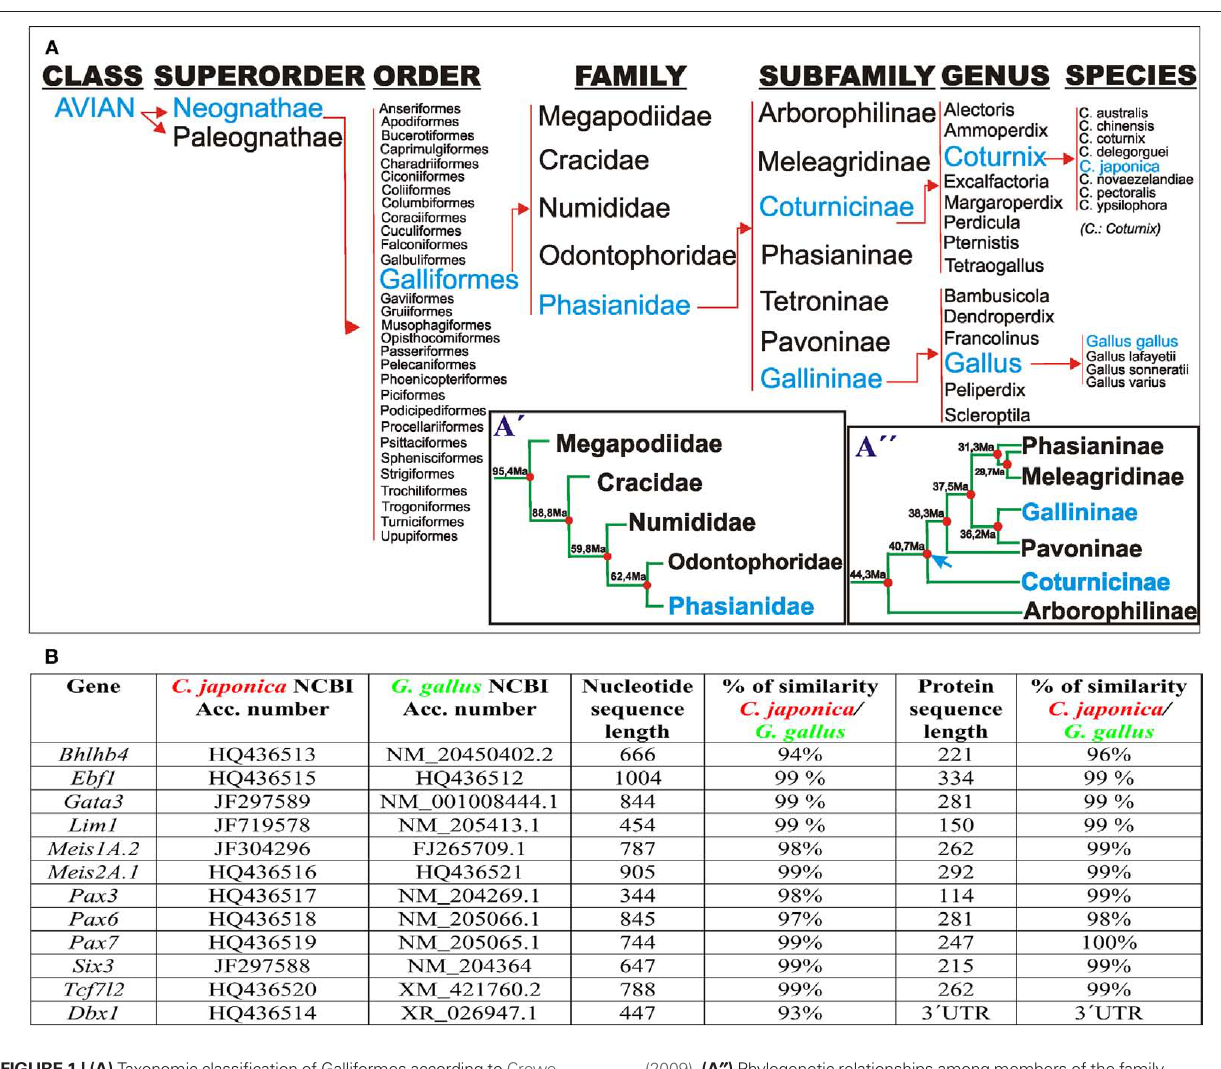
(2009). (A ′′ ) Phylogenetic relationships among members of the family Phasianidae according to Kan et al. (2010a,b). Blue arrow: time point of Gallininae and Coturnicinae split. (B) Comparison of the codifying and protein sequences of the listed genes between G. gallus and C.